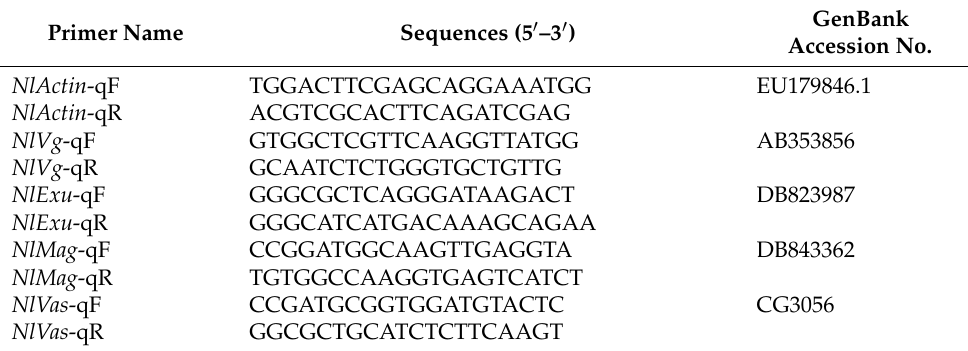
Table 1. Table 1. qRT-PCR